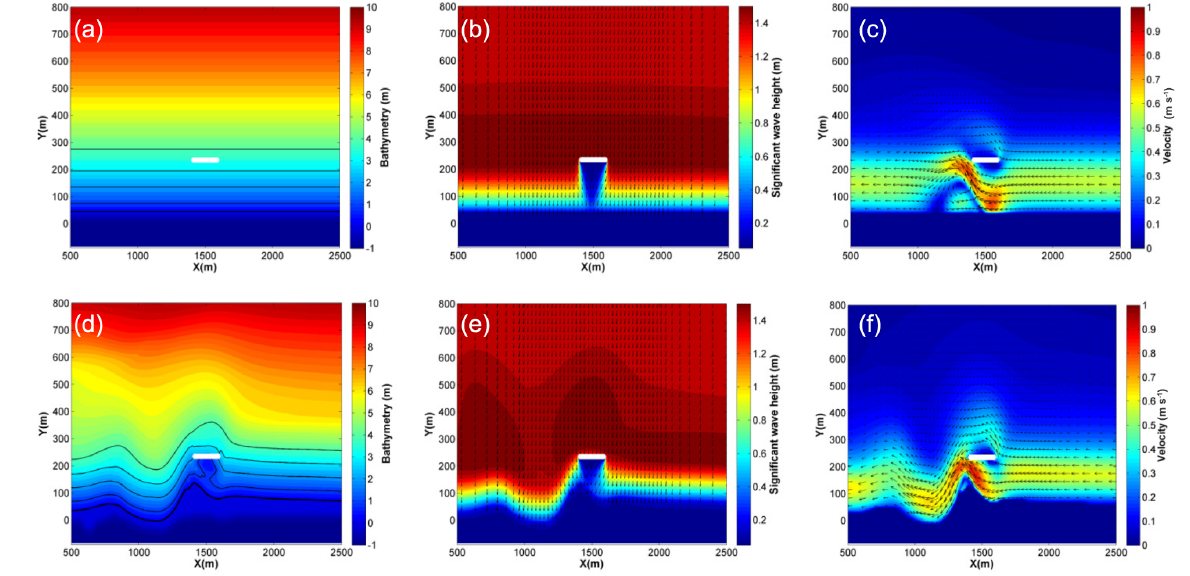
Figure 4. Model results for the breakwater’s length-to-distance ratio of 1.0. Bathymetry (a, d) , waves (b, e) , and currents (c, f) for the initial condition (a, b, c) and near equilibrium (d, e, f) after 27 years. The thicker isoline in the bathymetry represents the shoreline, whereas the others represent the 1, 2, 3, and 4m isobaths.